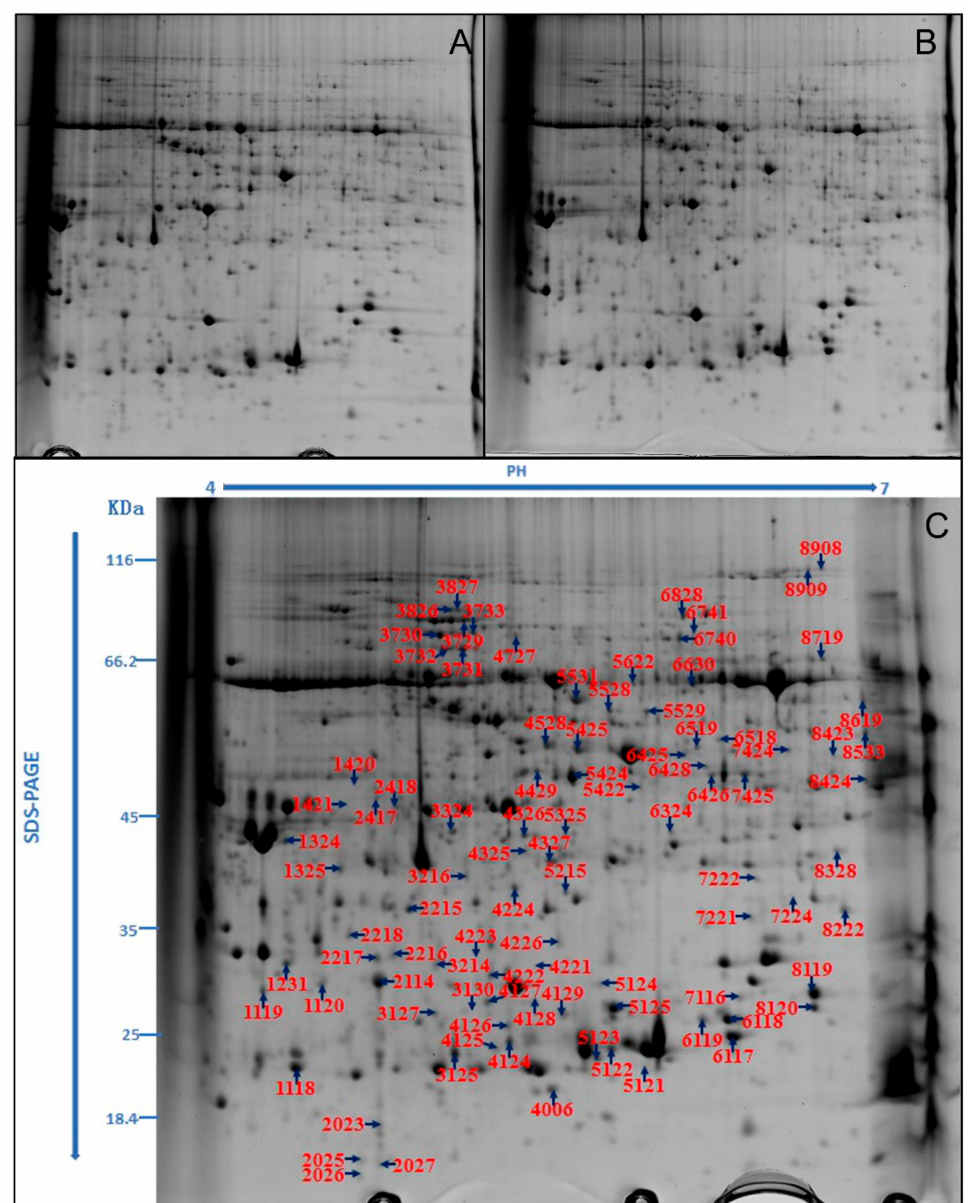
Figure 3. Representative 2-DE profiles of total proteins extracted from M. ‘Prairifire’ leaves treated with CG ( A ), and 38 ◦ C heat shock for 48 h ( B ). ( C ) Representative 2-DE profiles of di ff erential expressed proteins extracted from M. ‘Prairifire’ leaves between CG conditions and 38 ◦ C heat shock for 48